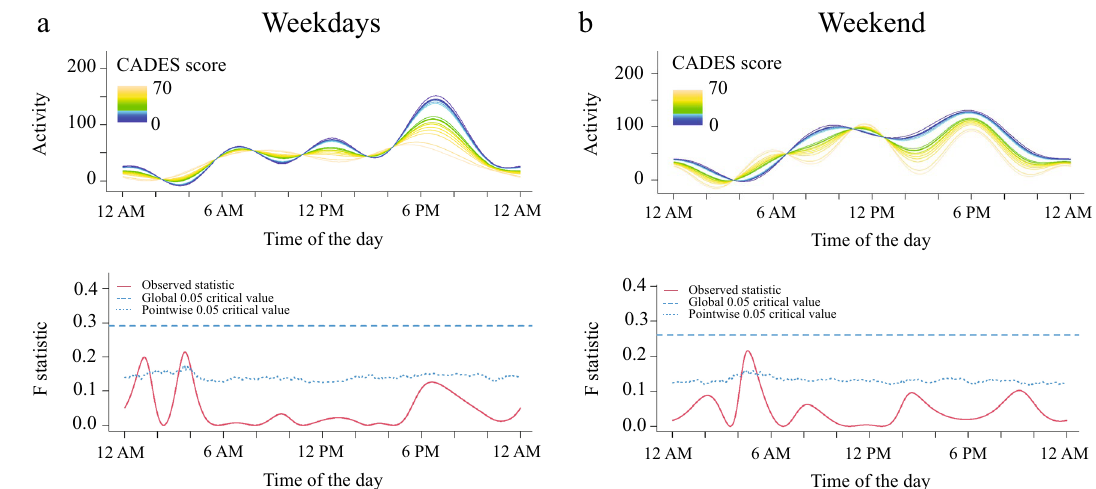
Figure 2. Relationship between CADES and activity levels in senior dogs on weekdays ( a ) and weekends ( b ). The upper graph illustrates activity over time for different levels of the variables analyzed and the lower graph indicates the level of significance of the differences. When the observed statistic (red line) is above the test of significance set at 0.05 (blue lines) it indicates significant differences between different levels of the variable. The dashed and the dotted lines indicate global and point-wise test of significance respectively. Dogs with higher CADES scores were more active between 3 to 5 AM during both weekdays ( a ) and weekends ( b ) and less active around 1